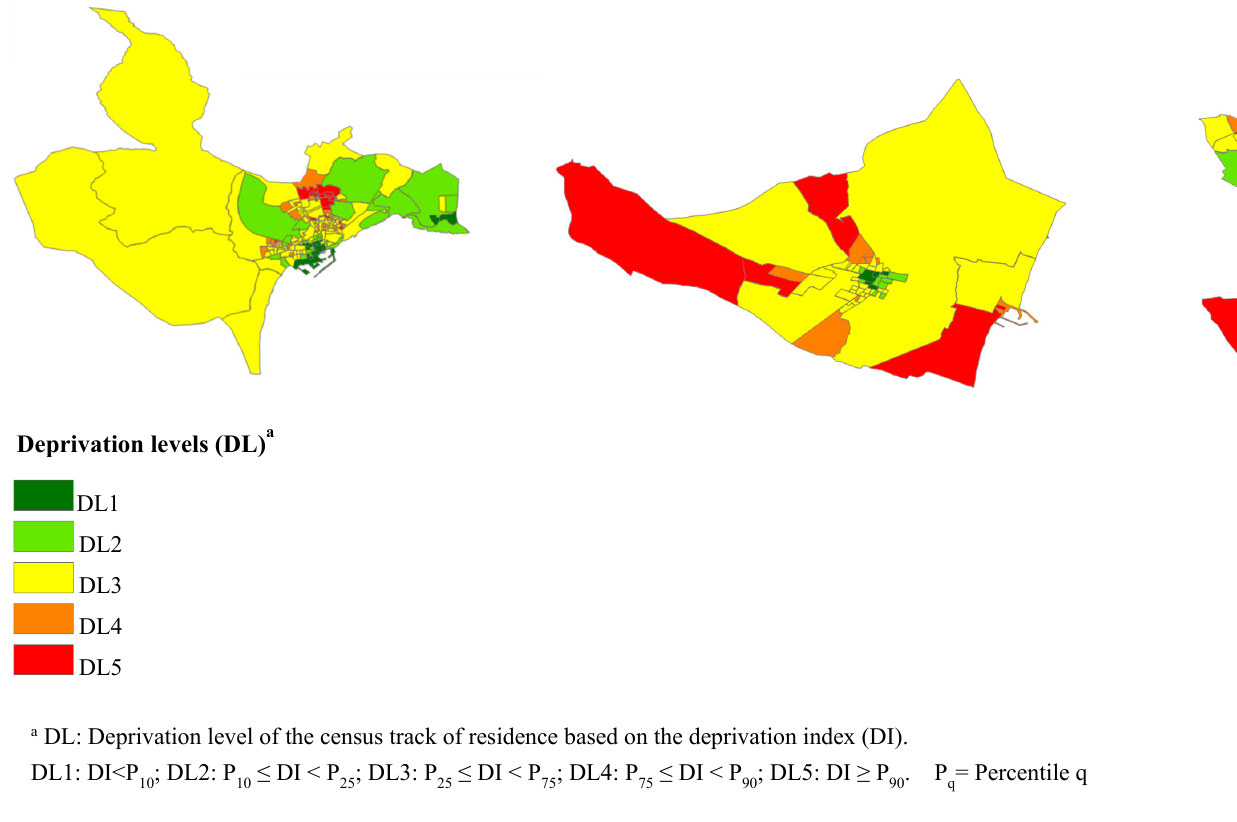
Figure 1. Geographical distribution of the five levels of deprivation (DL) according to census tracts in the cities of Alicante, Castellón and Valencia—2011.